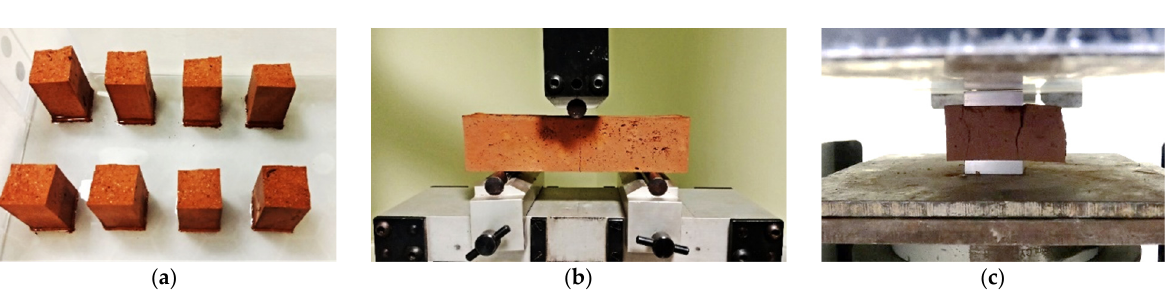
Figure 6. Test photographs: ( a ) Capillary water absorption; ( b ) flexural strength; ( c ) compressive strength.